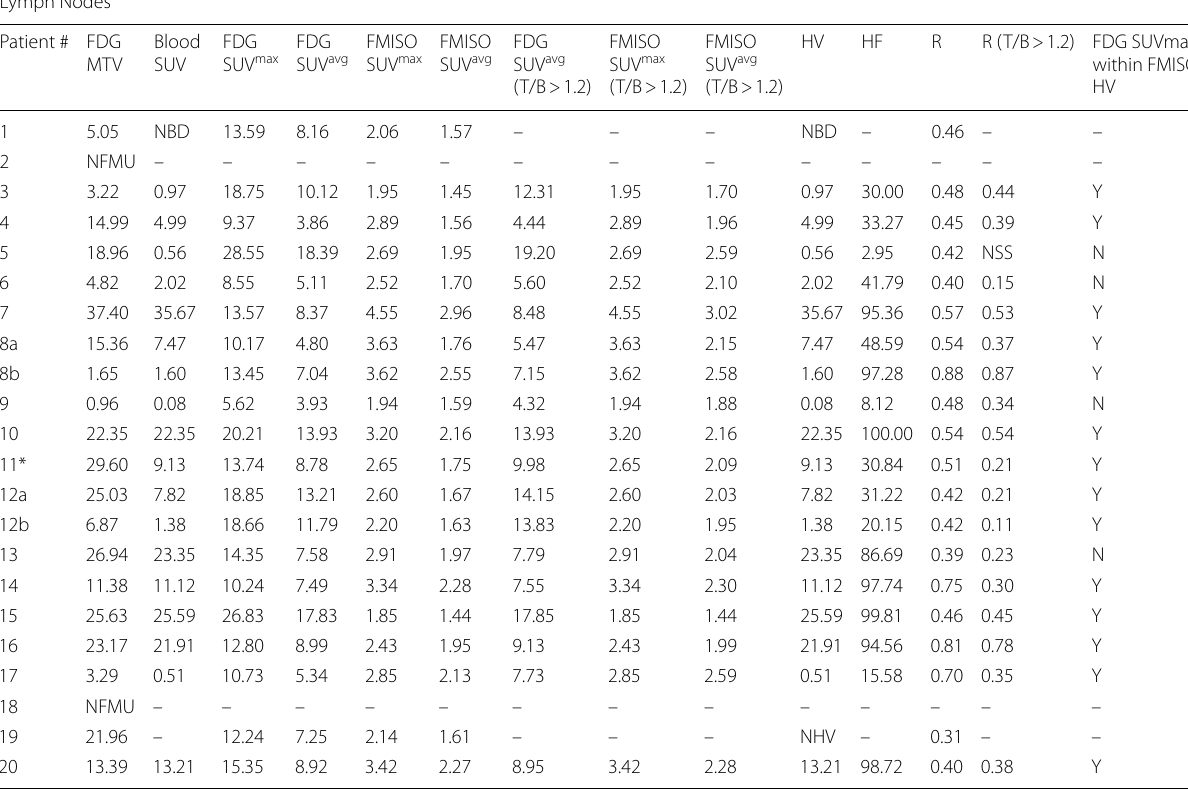
Table 3 Results summary for the LNs